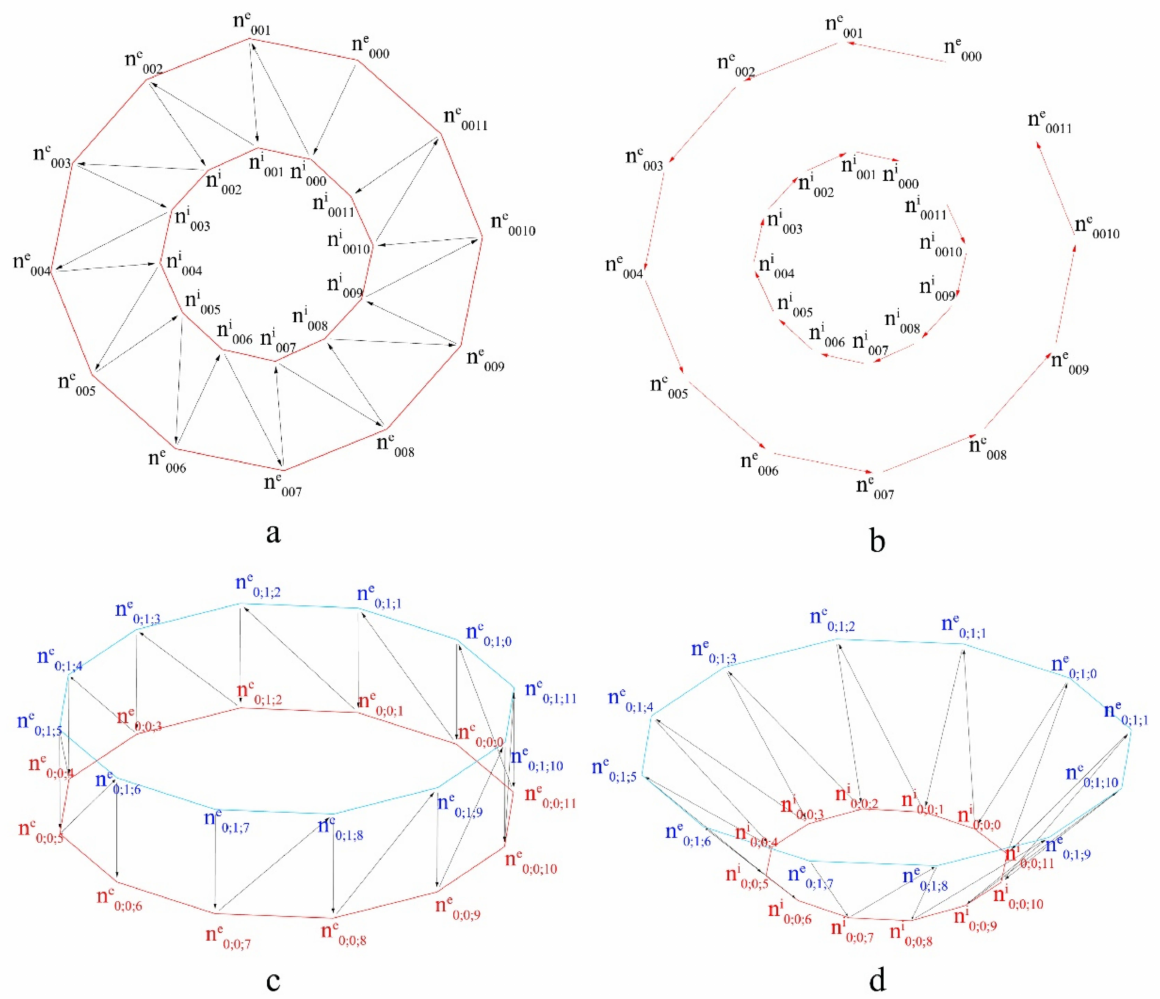
Figure 8. Lattice Generation: ( a ) horizontal zigzag printing; ( b ) horizontal printing; ( c ) vertical zigzag printing; ( d ) zigzag pattern between internal lower layer and external upper